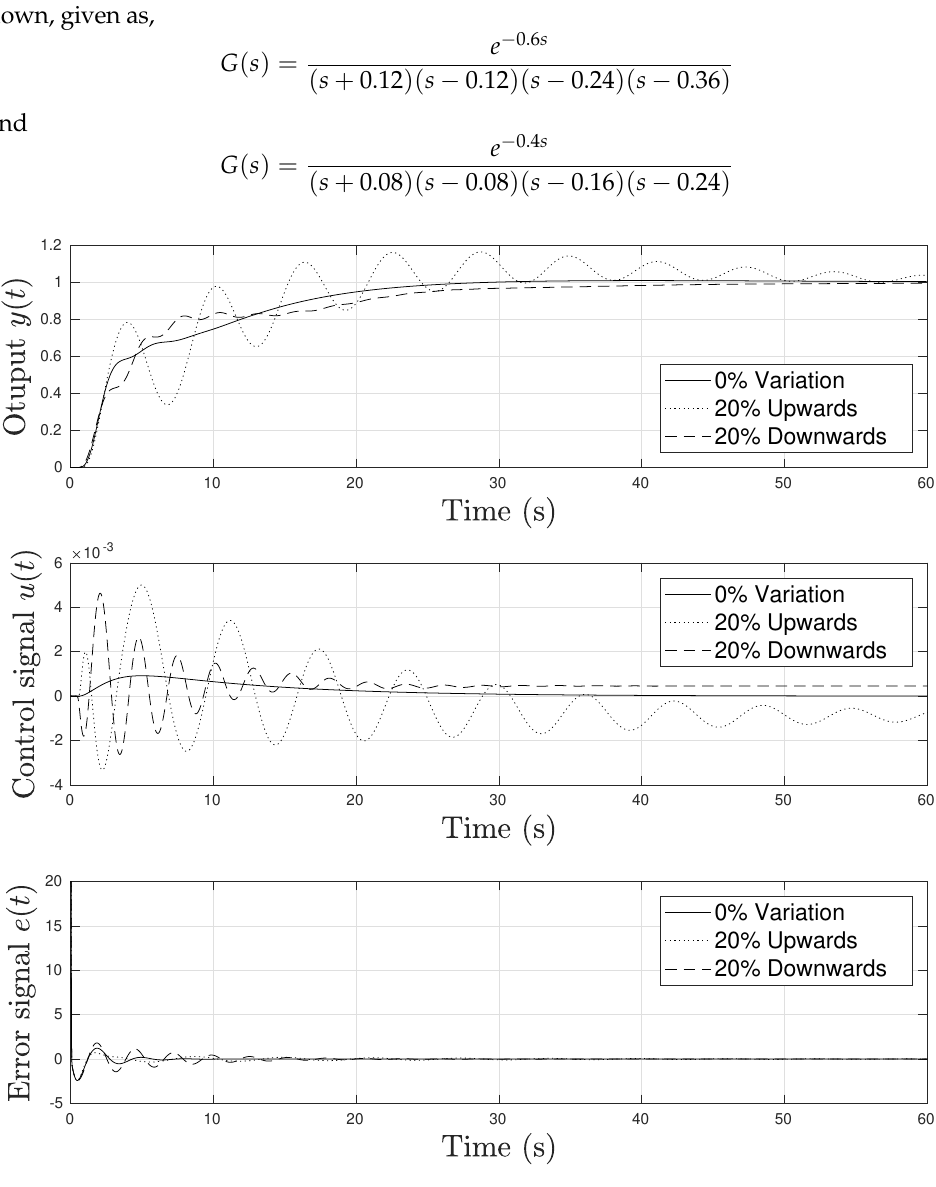
Figure 9. Response for three unstable poles for τ =